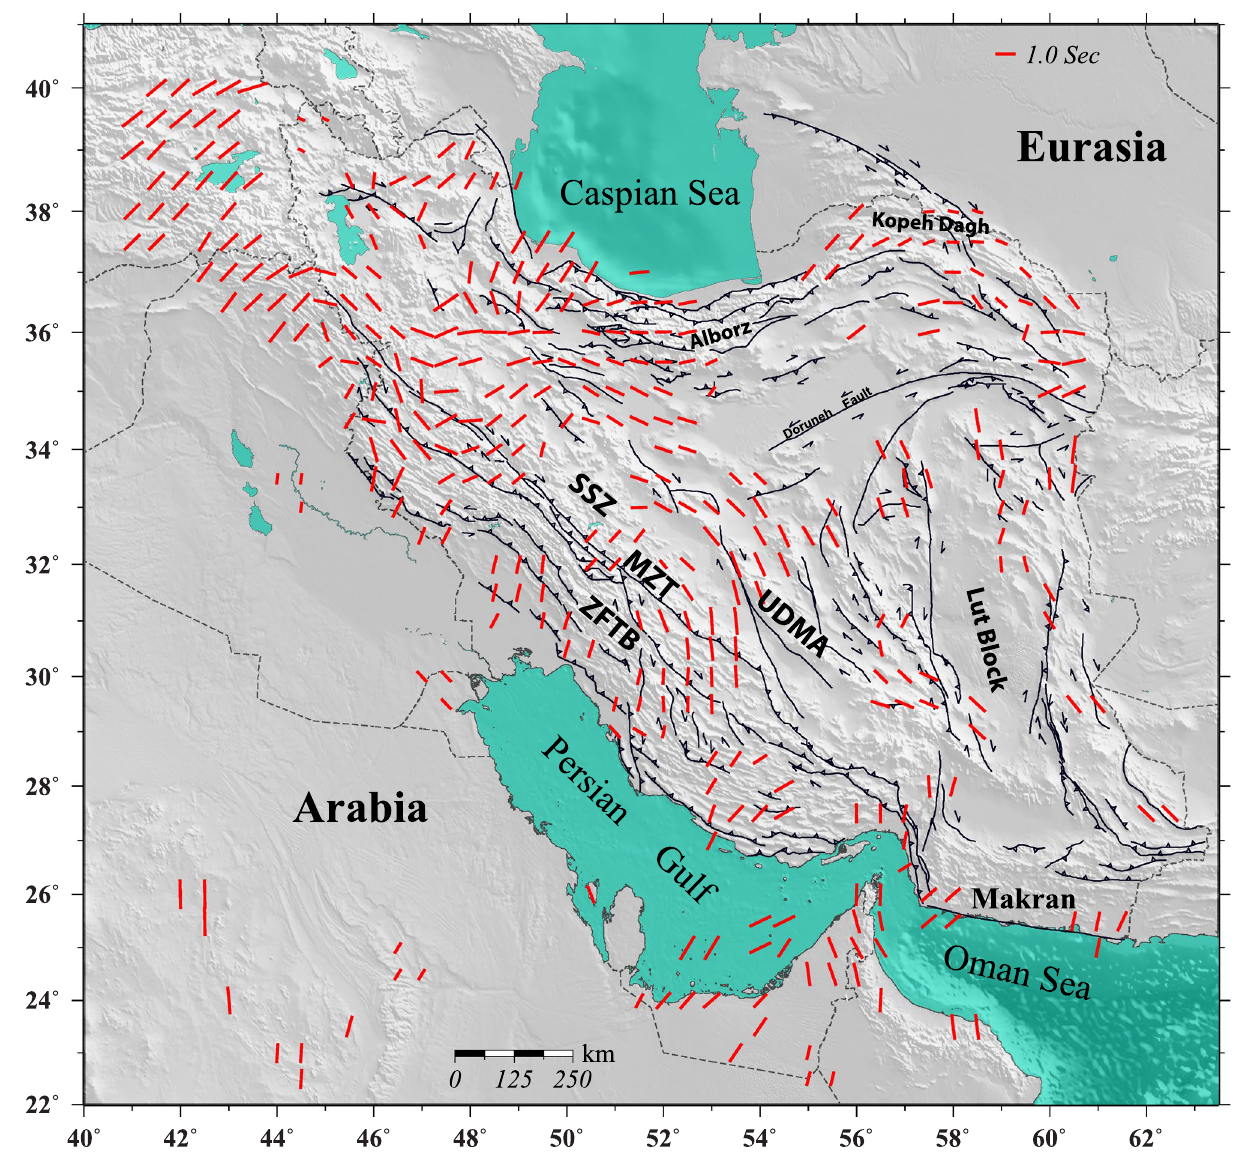
Figure 3. Interpolated anisotropy field at a depth of 150 km as calculated by averaging the directions at individual stations (see text for more explanation). Map is generated using the GMT 60 the region needs to be taken into account. Kaviani et al. 11 attempted to explain the pattern of seismic anisotropy across the Iranian Plateau by simple shearing related to the major strike-slip fault zones. Here, we compare the anisotropy directions with the maximum shear strain rate vectors across the study area (Fig. 4a). The two orthogonal directions of the maximum shear-strain rate represent either right- or left-lateral motions along the fault zones in each region. Despite an apparent correlation between the observed azimuthal anisotropy and the maximum shear strain rate directions in some regions, the magnitude of the shear strain rate vectors suggests insignificant shearing along the strike-slip zones. This may suggest that the strike-slip fault systems in Iran do not affect the whole lithosphere which is required for the development of pervasive anisotropy in the vicinity of the shear zones. Only in eastern Iran, we observe a more significant azimuthal correlation between the anisotropy orientations and maximum shear directions with relatively large strain rates. In this region, the fast directions of azimuthal anisotropy are mainly oriented in an N–S trend subparallel to the strike of the fault systems (Fig. 2) that accommodate the relative motion between the Lut and Helmand blocks 3,35–37 . This implies that the strike-slip fault system in eastern Iran likely acts as a major plate boundary zone capable of producing pervasive anisotropy. Previous numerical modeling studies of viscoplastic deformation 24 suggest that mountain-parallel LPO can develop by ductile deformation (pure shear) in the uppermost mantle induced by belt-perpendicular compressive stresses. This mechanism can explain the observations of belt-parallel seismic anisotropy in some mountain belts such as the Alps and Central Asia 28 . Overall, our observations exhibit a low azimuthal correlation between the directions of horizontal extensional strain rates (pure shear) and seismic anisotropy (Fig. 4b). In regions with an apparent correlation (such as along the narrow band in central Iran where the fast polarizations are NW–SE